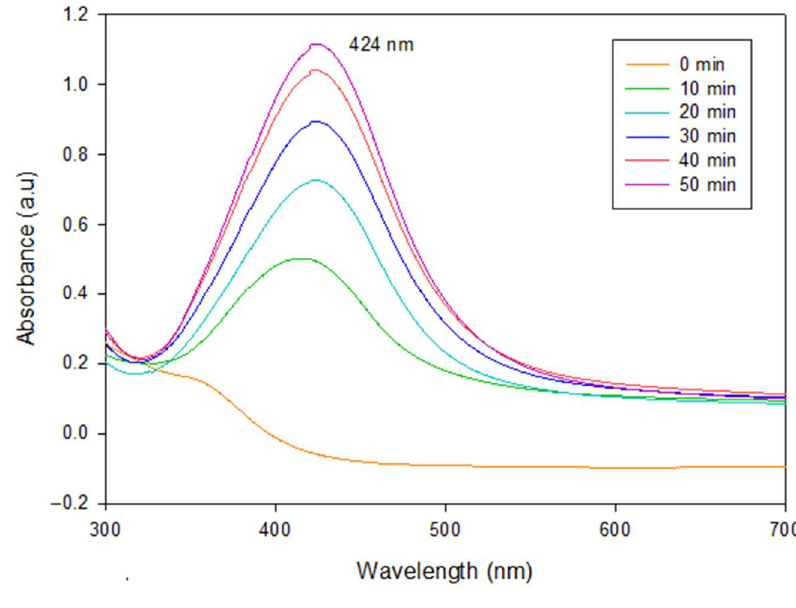
Figure 1. UV–Vis absorption spectra of AgNPs taken at different synthesis times.